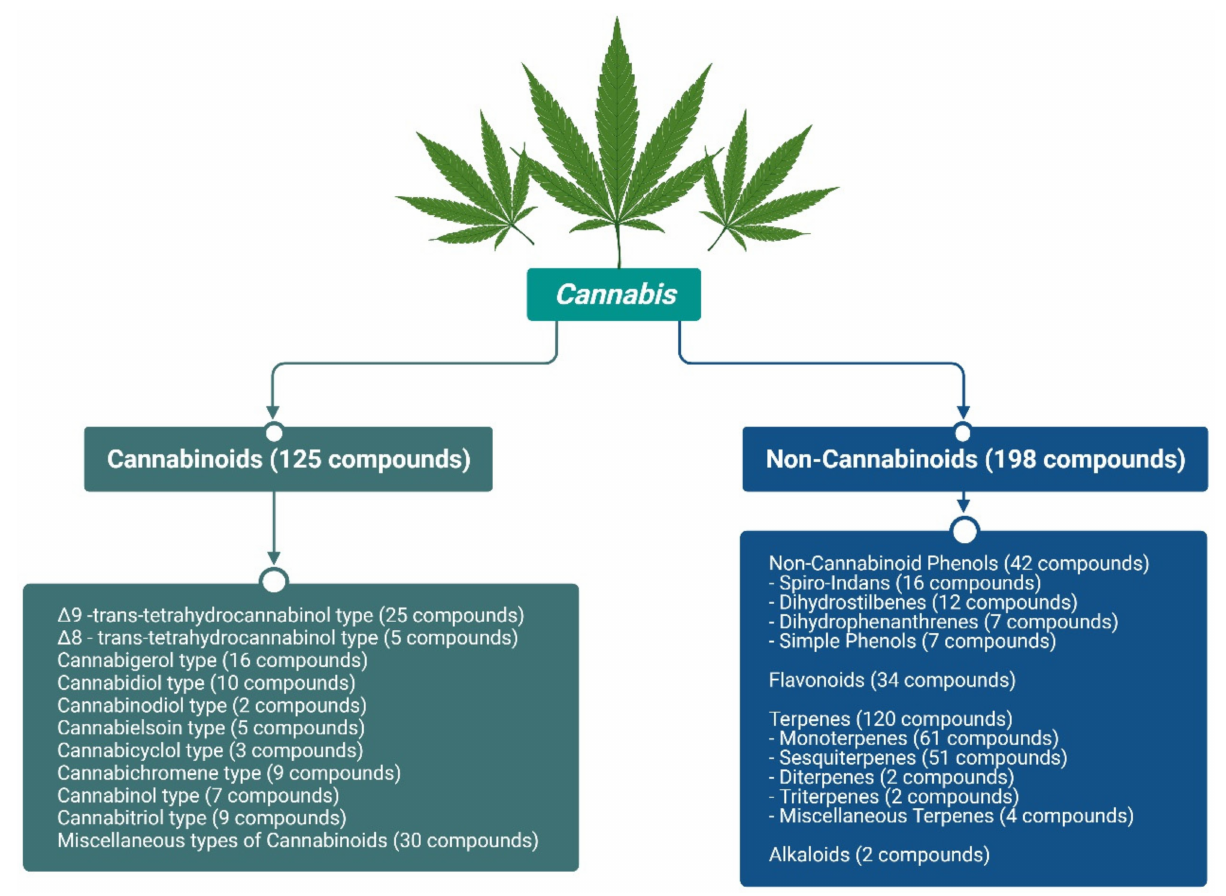
Figure 2. Major phytochemicals identified from